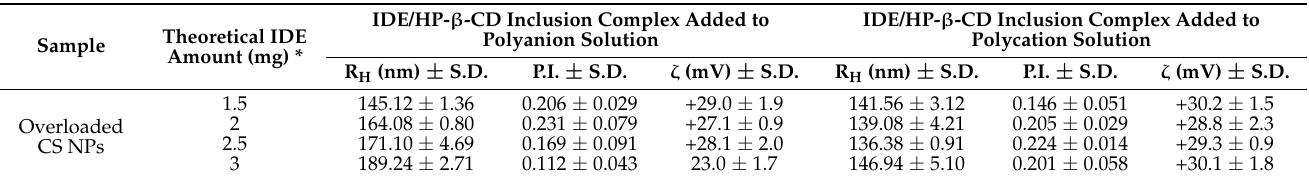
Table 2. Hydrodynamic radius (R H ), polydispersity index (P.I.), and zeta potential ( ζ ) of CS NPs pre- pared using the IDE/SBE- β -CD inclusion complex (1:2 molar ratio) as a gelling agent and overloaded with different concentrations of the IDE/HP- β -CD inclusion complex (1:2 molar ratio) (overloaded CS NPs). The values are expressed as the mean of six batches ± standard deviation (S.D.).